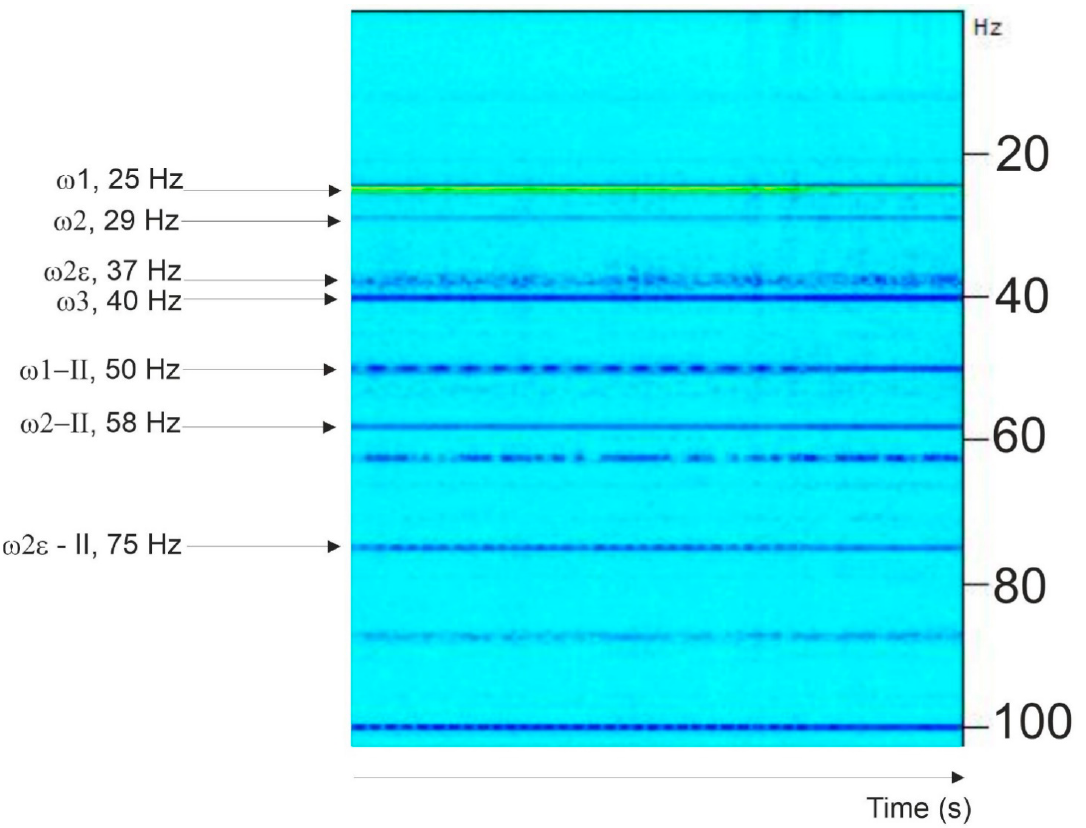
Figure A2. Frequency analysis of ring mill angular speed: 25 Hz (1500 RPM) = jar; 29 Hz (1740 RPM) = ring; 37 Hz (2220 RPM) = ring eccentric;40 Hz (2400 RPM) = cylinder inside ring.